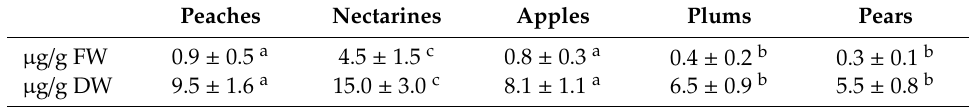
Table 1. Content of abscisic acid in fruit thinning waste products. Peaches Nectarines Apples Plums Pears µ g / g FW 0.9 ± 0.5 a 4.5 ± 1.5 c 0.8 ± 0.3 a 0.4 ± 0.2 b 0.3 ± 0.1 b µ g / g DW 9.5 ± 1.6 a 15.0 ± 3.0 c